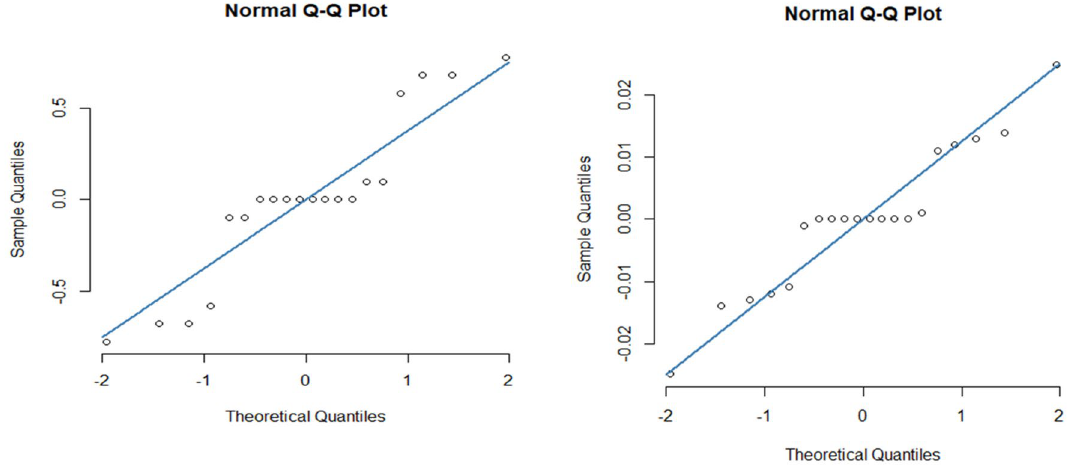
Figure 10. The residual normal ( Q